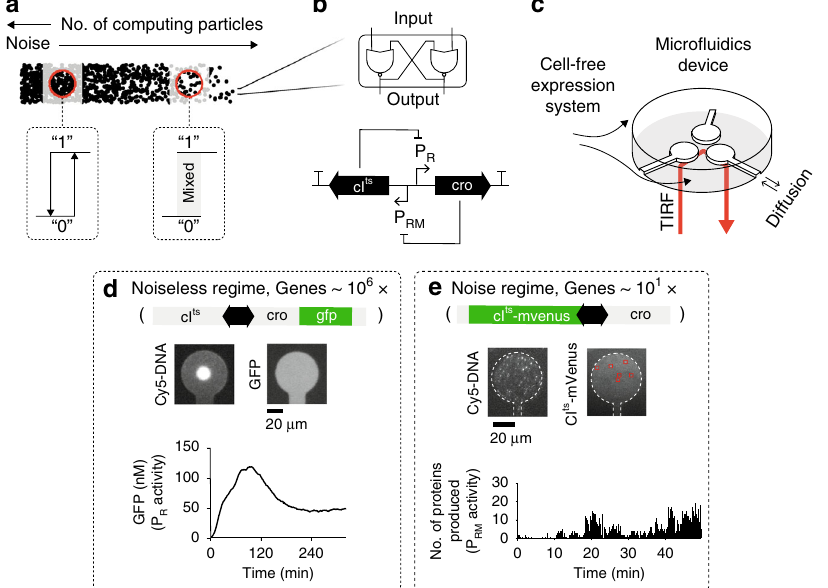
Fig. 1 Biological decision-making in an arti fi cial cell at high and low gene densities. a Number of particles in fl uence decision-making by an effective noise level: a bistable GRN responds to an input with a binary output in the noiseless regime at large numbers, or by a fuzzy output in the noise regime at small numbers. b Scheme of the minimal bistable GRN based on CI and Cro transcription factors repressing each other ’ s promoter with analogy to an electronic latch circuit. c Scheme of a micro fl uidic device with three compartments as arti fi cial cells and total internal re fl ection fl uorescence (TIRF) microscopy to monitor protein production at low gene densities in a cell-free expression system 30 . d Cy5-DNA assembled in a compartment at high density gives rise to GFP expression reporting on the P R activity. e Cy5-DNA at single-molecule resolution inside the compartment. Single CI ts -mVenus were integrated over the compartment to give the number of proteins produced in 15 s, reporting on the overall P RM activity. Source data are provided as a Source data fi